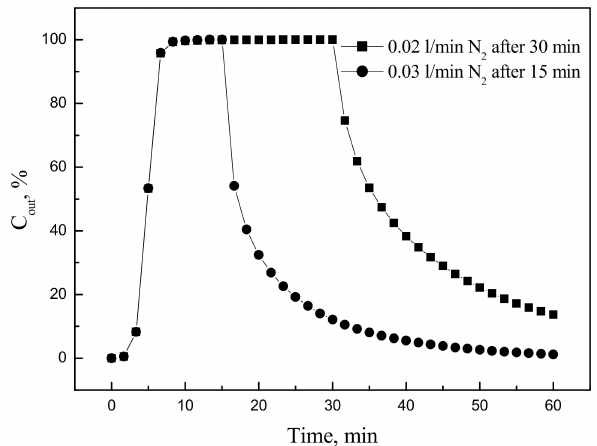
Figure 11. Breakthrough curves of the desorption of CO 2 loaded CFAZ simulated by ProSim DAC